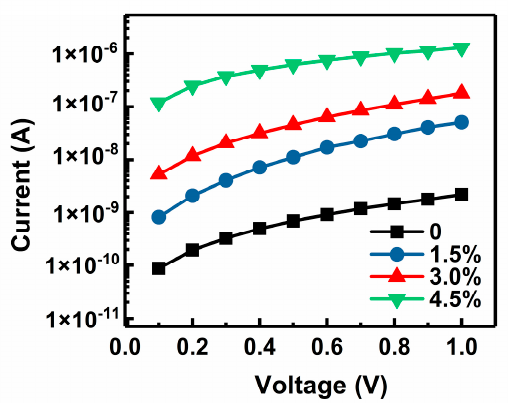
Figure 6. I – V curves of an undoped MgO film sample and three Au-doped MgO film samples with doping concentrations of 1.5%, 3.0%, and 4.5%.